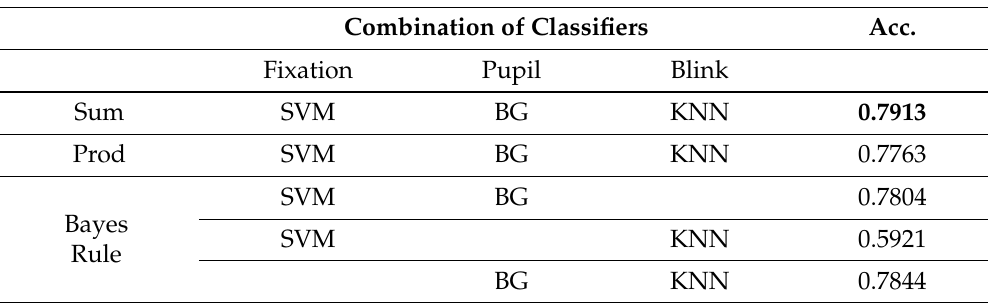
Table 7. The results of the combination of the classifiers in age recognition using different transformation-based score techniques without a a preliminary feature level fusion. The numbers in bold are the best results.